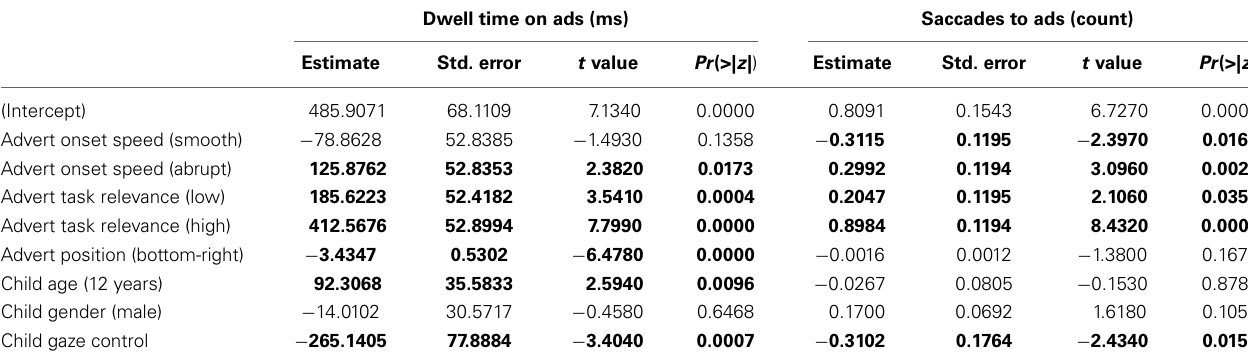
Table 2 | Effects of independent variables on task distraction measures (dwell time on ads and saccades to